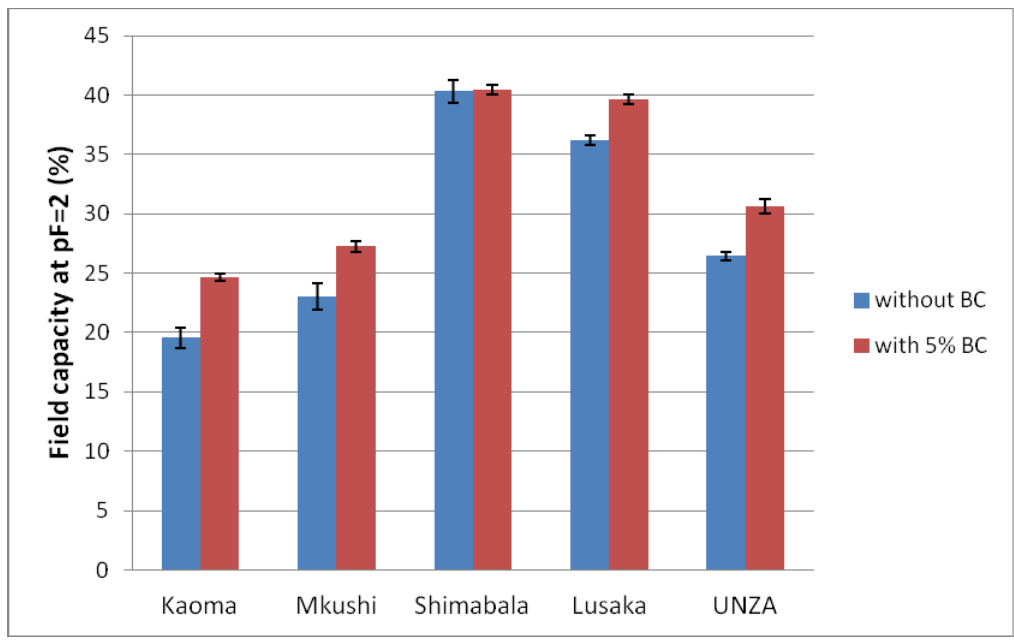
Figure 4. Field capacity (pF = 2) with (red bars) and without (blue bars) 5% maize cob biochar, for the five soils in hand-packed cylinders with mixed-in